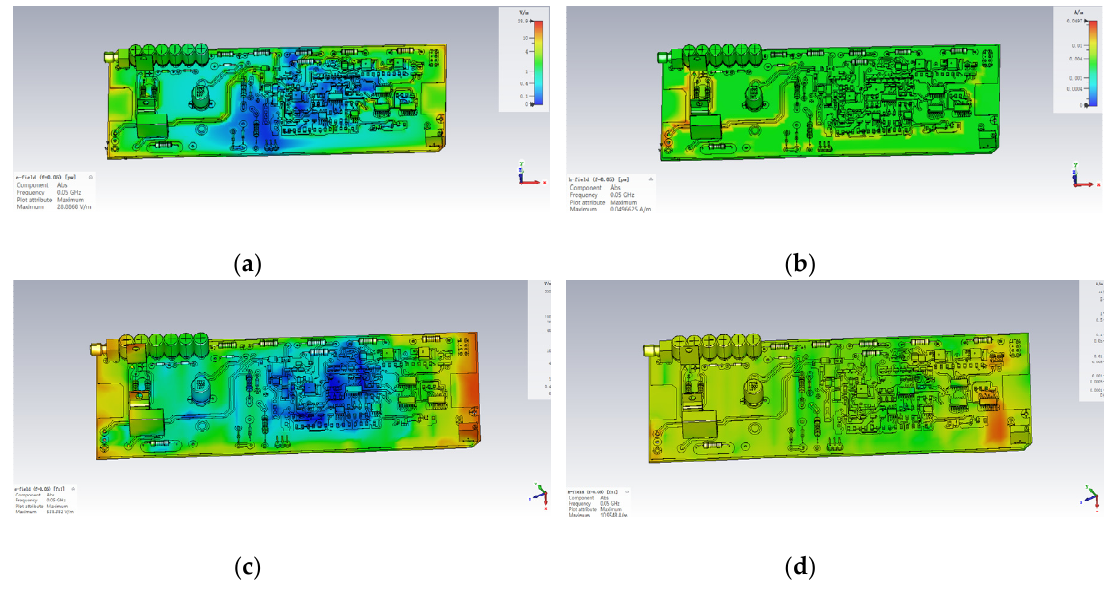
Figure 6. ( a ) Electric field distribution diagram under far-field disturbance; ( b ) Magnetic field distribution diagram under far-field disturbance; ( c ) Electric field distribution diagram under near-field disturbance; ( d ) Magnetic field distribution diagram under near-field disturbance.